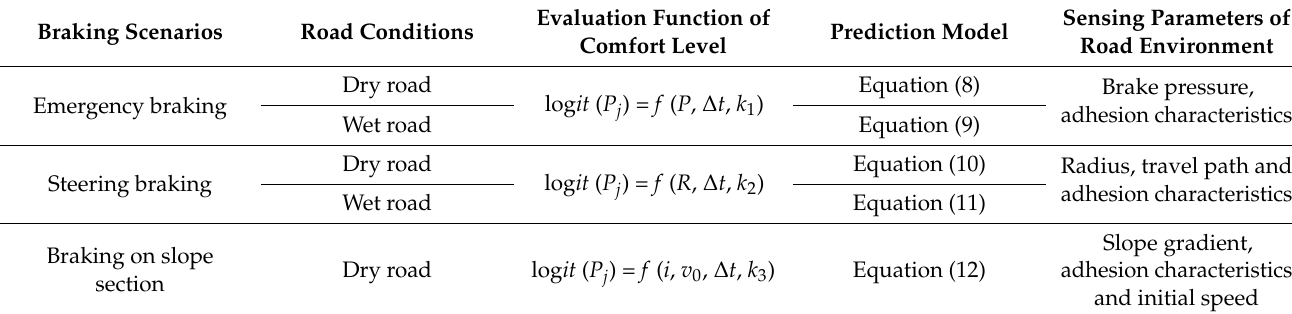
Table 9. Sensing parameters of the road environment based on ride